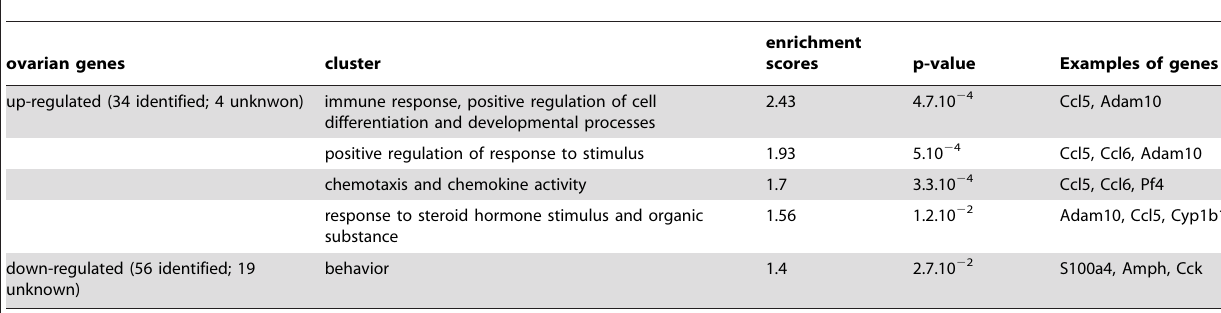
Table 4. David functional analysis.